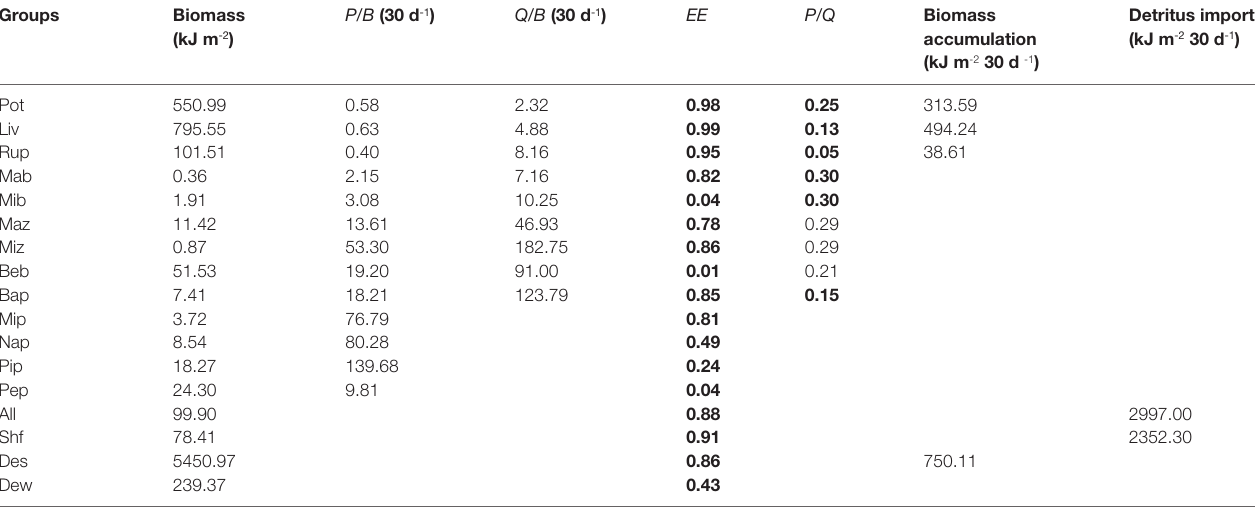
Values in bold are the parameters estimated by the model. Group abbreviations as in Table 2 .